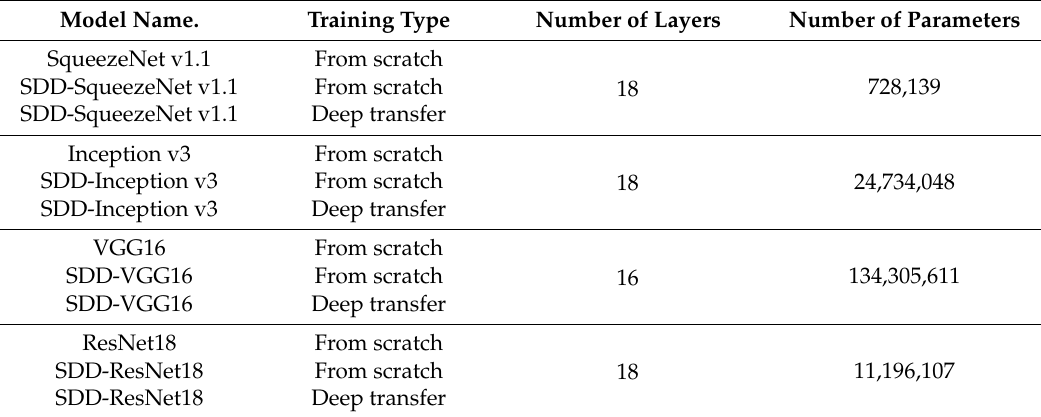
Table 4. Training strategies and basic scales for four CNN